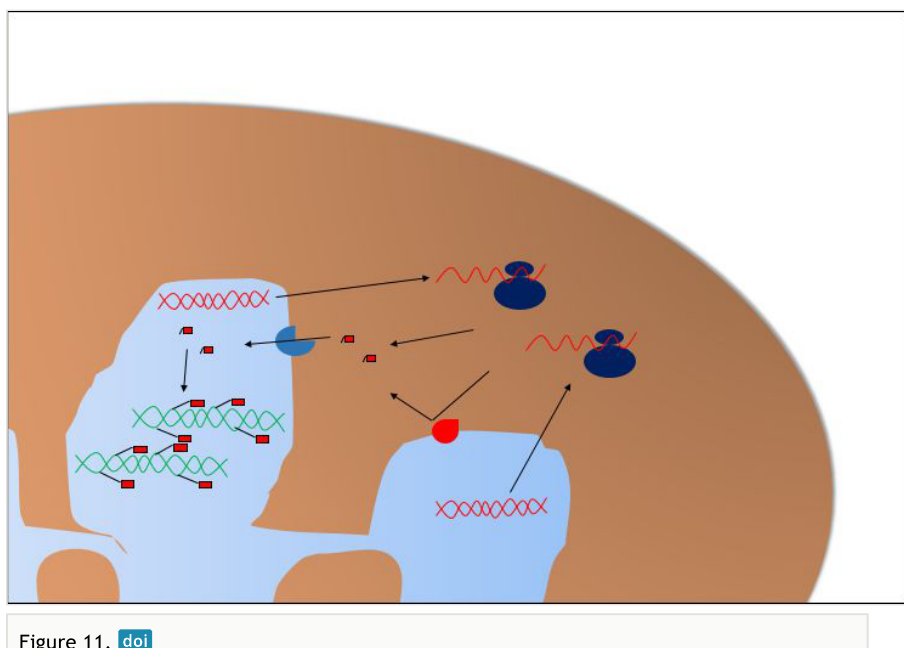
Figure 11. Protein transcription factors would be synthesised in the cytoplasm, so their genes can be in any lobe. Their presence in each lobe would depend on the properties of its nuclear pores. In the image, red pore complexes would reject the factor while the blue ones facilitate their importation into the